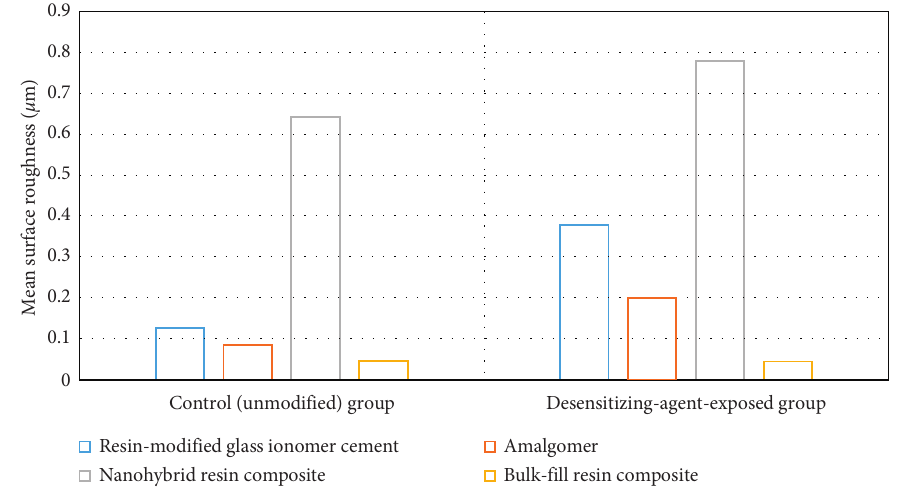
Figure 4: Graphical presentation of ANOVA results of surface roughness ( μ m) of the tested materials. Table 3: ANOVA and post hoc tests of the color difference results for the different restorative